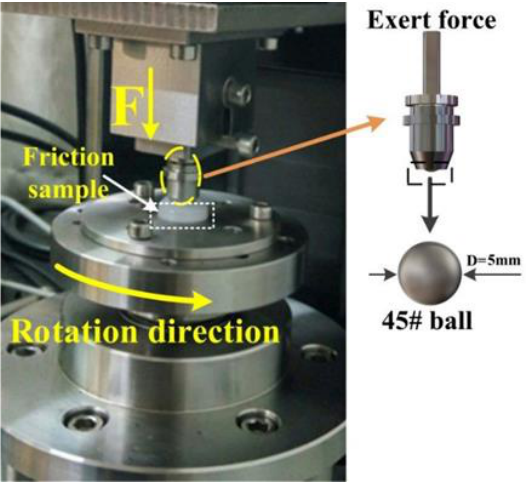
Figure 1. Schematics of the test configuration.